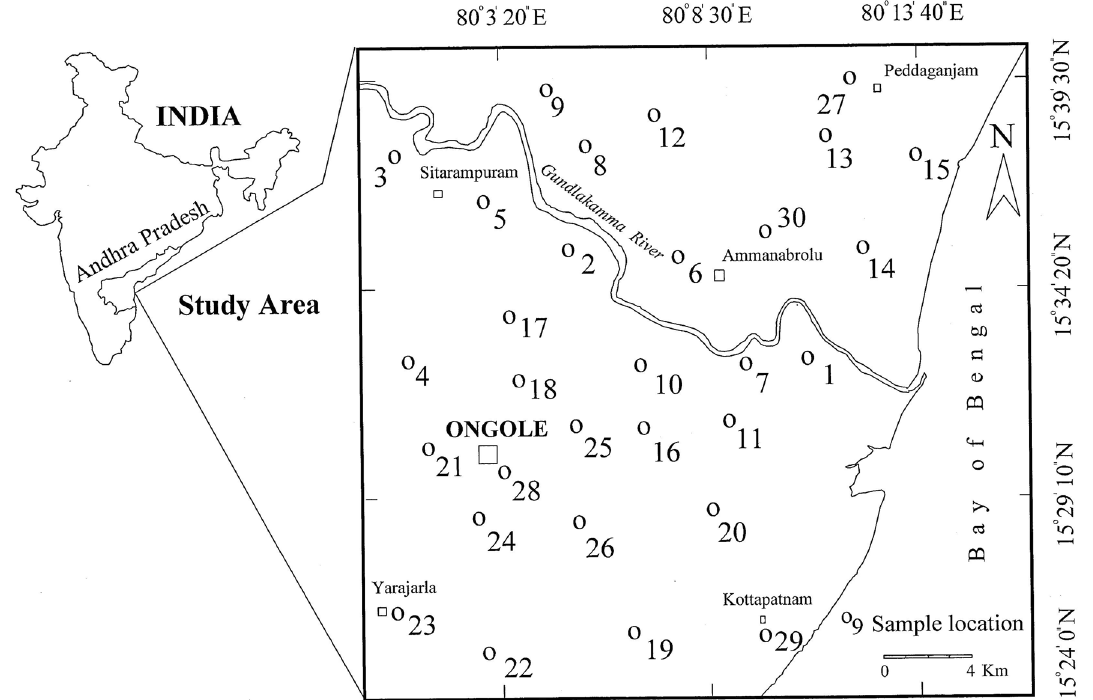
Fig. 1 Location of the study